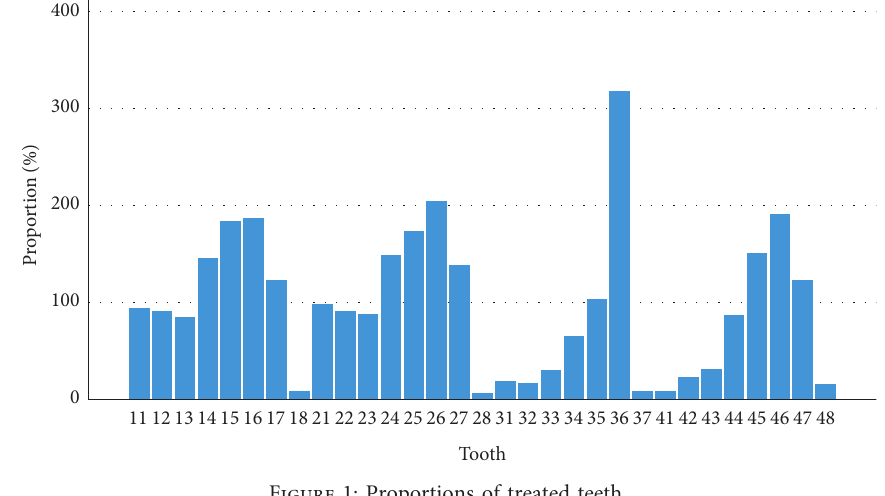
Figure 1: Proportions of treated Table 1: Distribution of categorical variables.